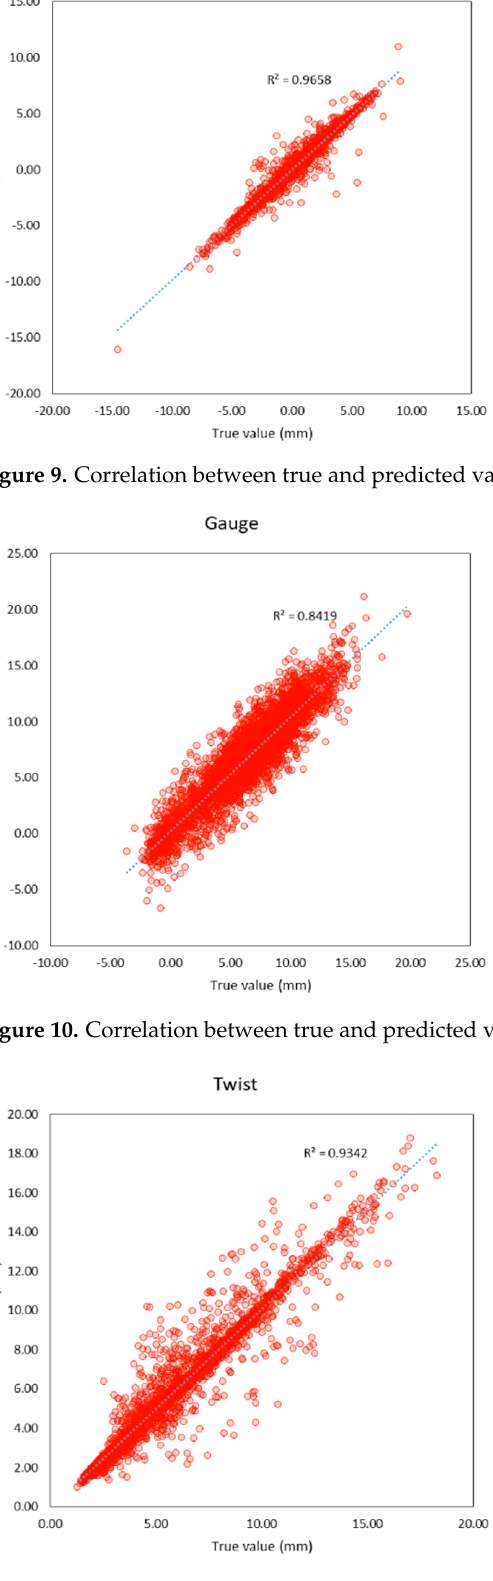
Figure 11. Correlation between true and predicted values of twist.